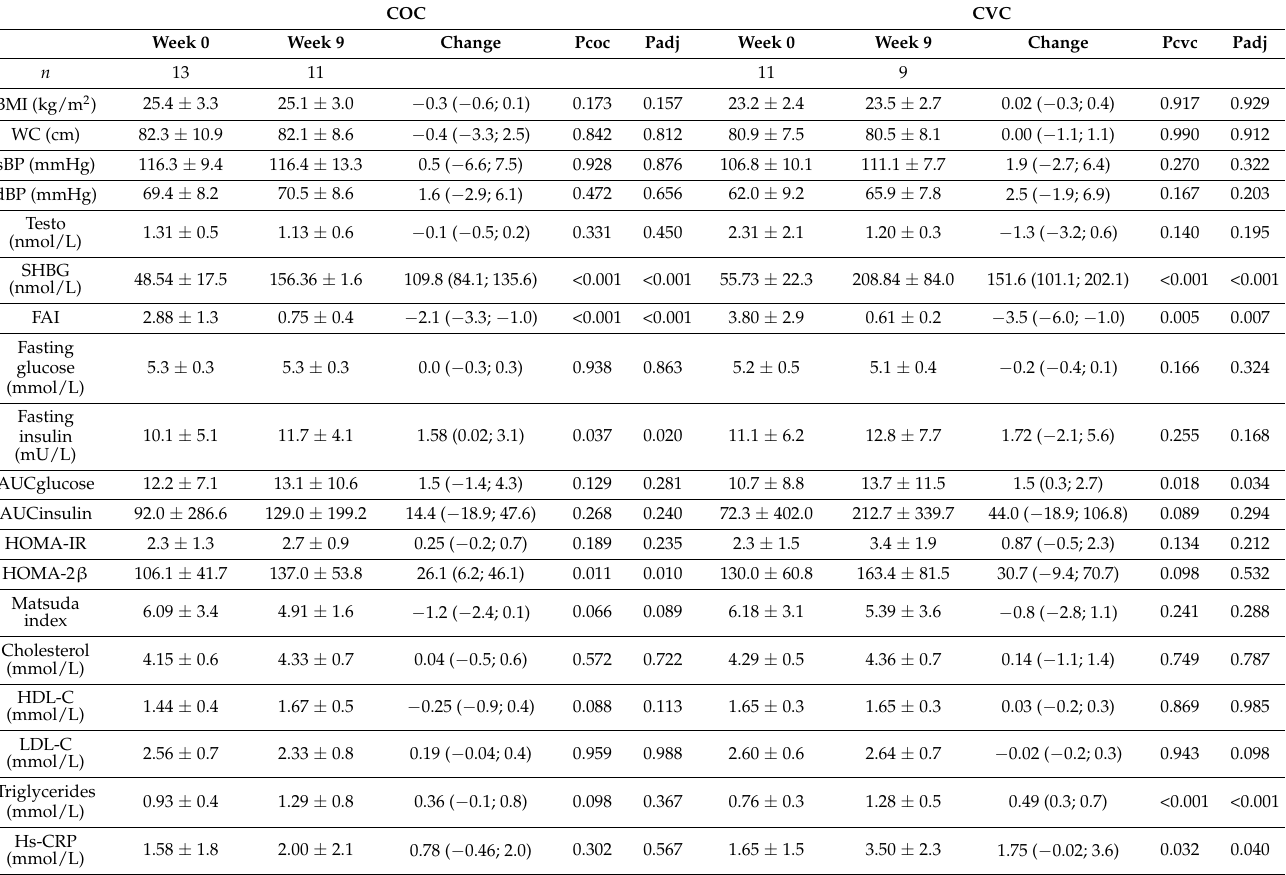
Table 3. Parameters (mean ± standard deviation, SD) related to androgen secretion, glucose metabolism, lipid profile, and inflammation in the study